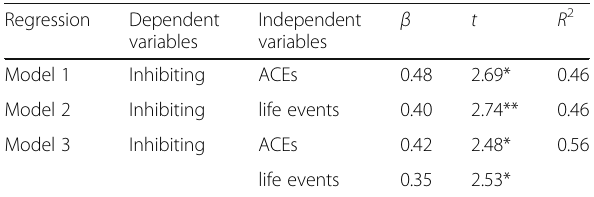
Table 6 Regression analysis Regression Dependent